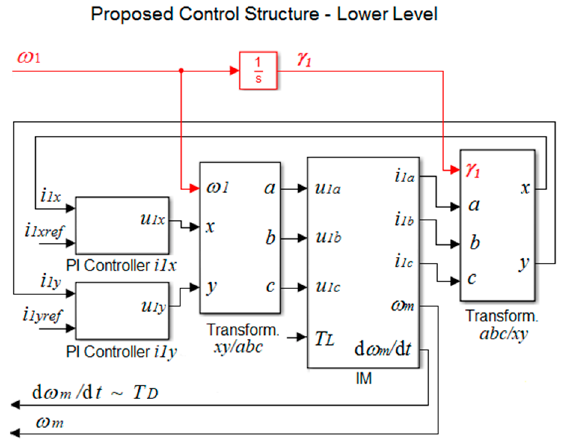
Figure 9. The lower control level of the proposed control structure, where γ 1 is the instantaneous position of the stator voltage vector and u 1 x , u 1 y are the components of the stator voltage space vector u x .